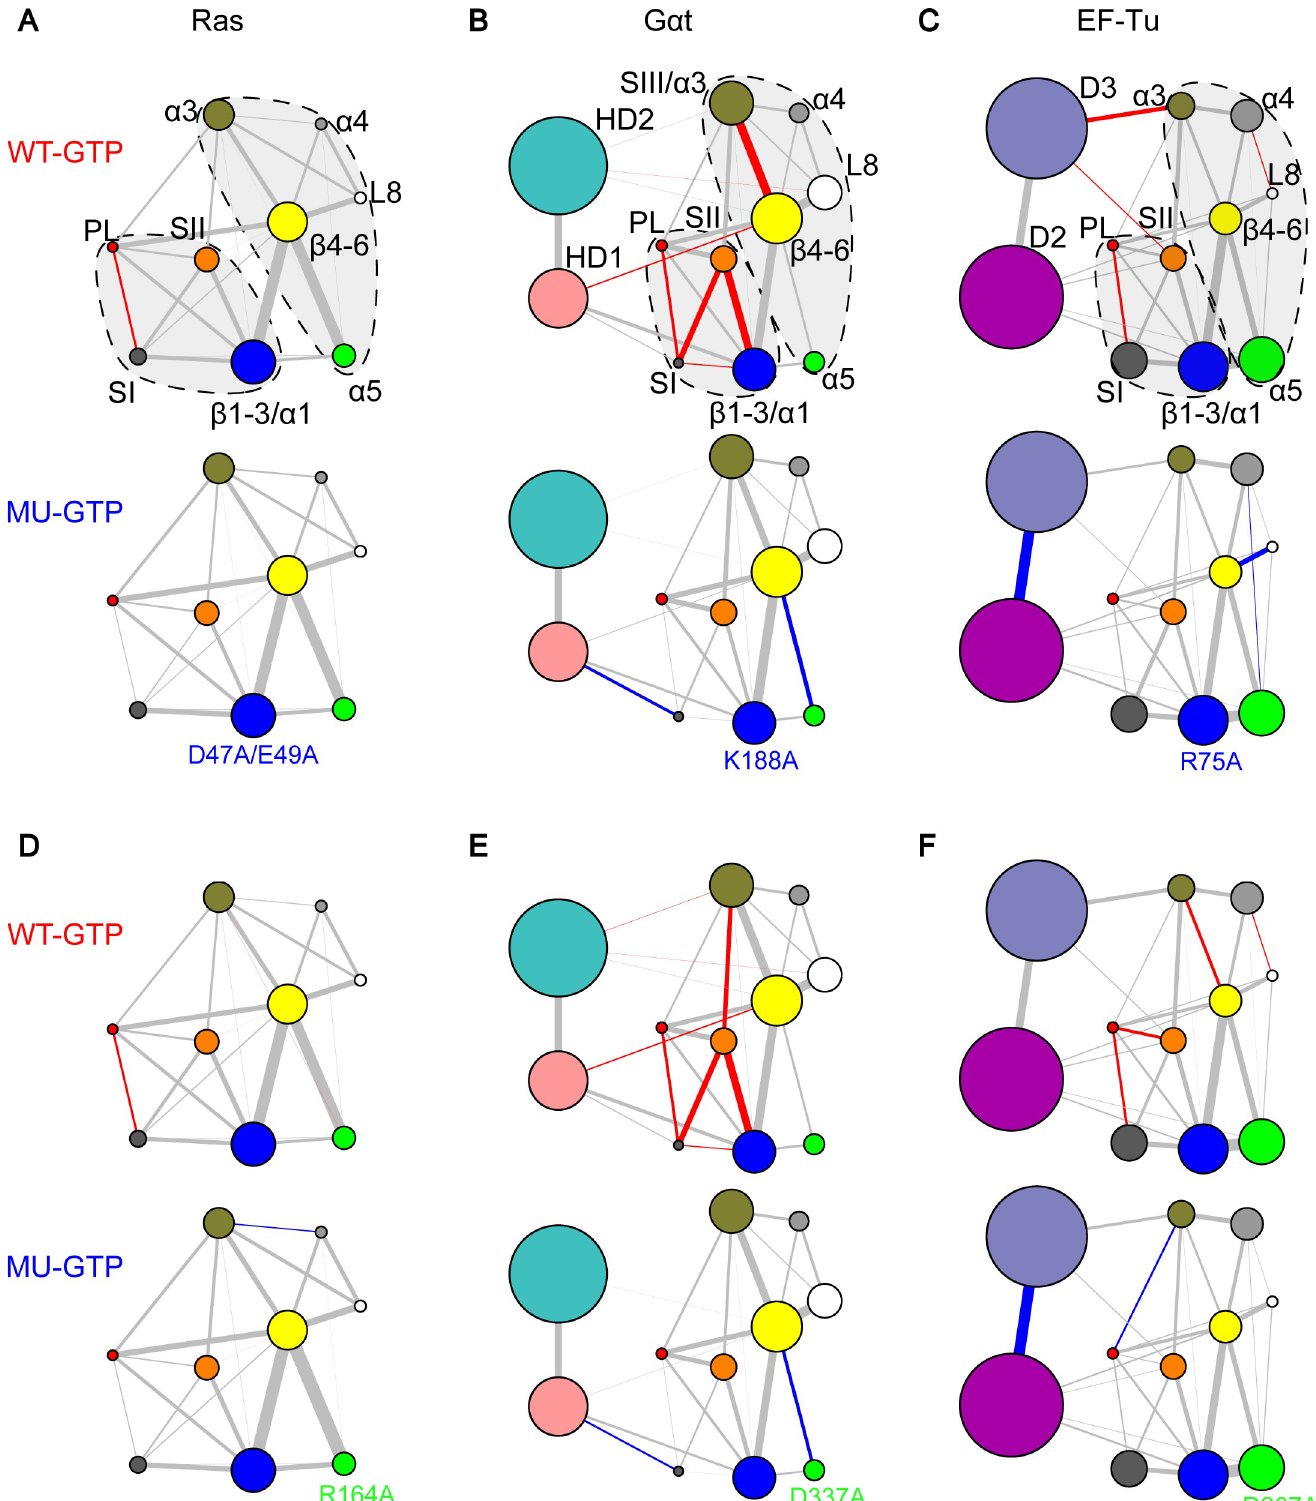
Fig 6. Mutations of common residue-wise determinants of structural dynamics between L3 and α 5 have similar effects in Ras, G α t and EF-Tu. Mutations D47A/E49A Ras in L3 ( A ) and R164A Ras in α 5 ( D ) significantly reduce the couplings between PL and SI. The counterpart mutations in G α t and EF-Tu, K188A G α t in